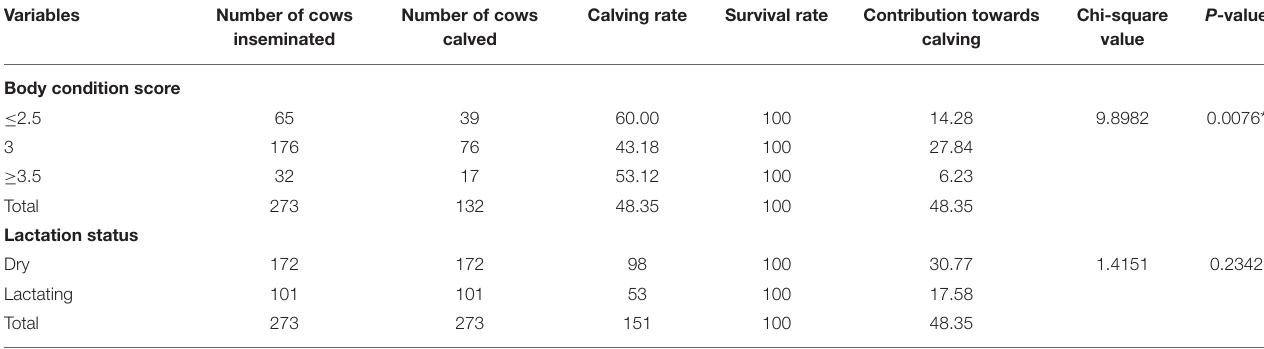
TABLE 8 | Effect of body condition score and lactation status on calving and survival rate of cows under communal and emerging farming systems. Variables Number of cows